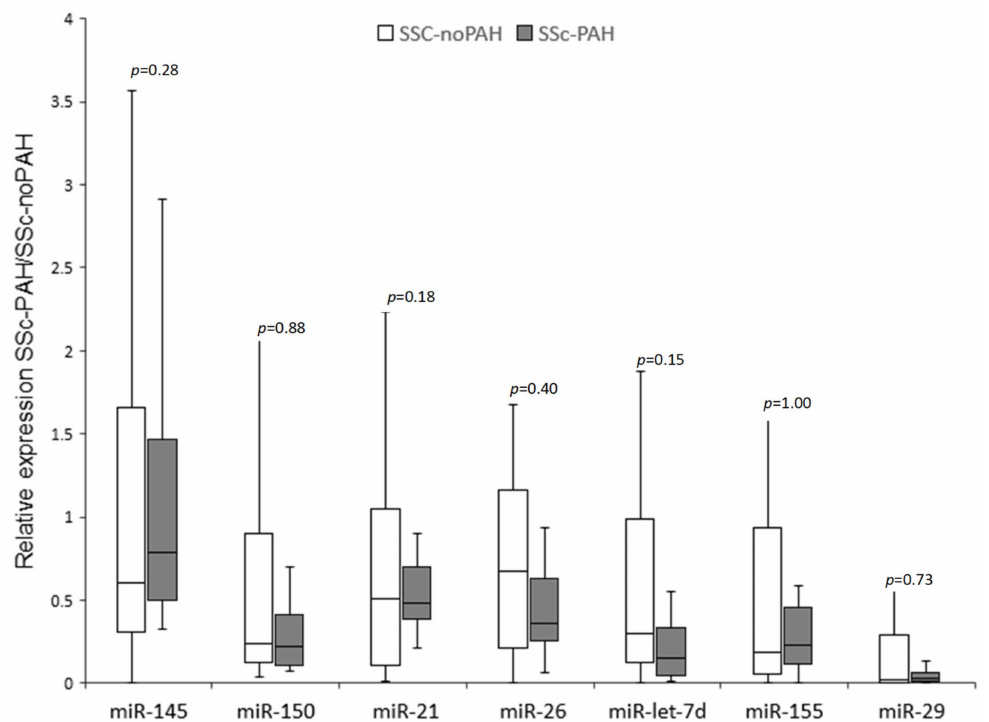
Figure 1. Median miRNA levels in the plasma of SSc patients with and without PAH. RNA was isolated from plasma of 25 SSc-noPAH and 12 SSc-PAH patients. The levels of seven miRNAs were evaluated by qRT-PCR. miR-16 served for normalization. The boxplot presents five values (minimum: (Q1–1.5*IQR); first quartile (Q1/25th percentile); median; third quartile (Q3/75th percentile); and maximum (Q3 + 1.5*IQR)) of the miRNAs. miR: miRNA; PAH: Pulmonary arterial hypertension; SSc-noPAH: Patients with SSc without PAH; SSc-PAH: Patients with SSc and PAH.